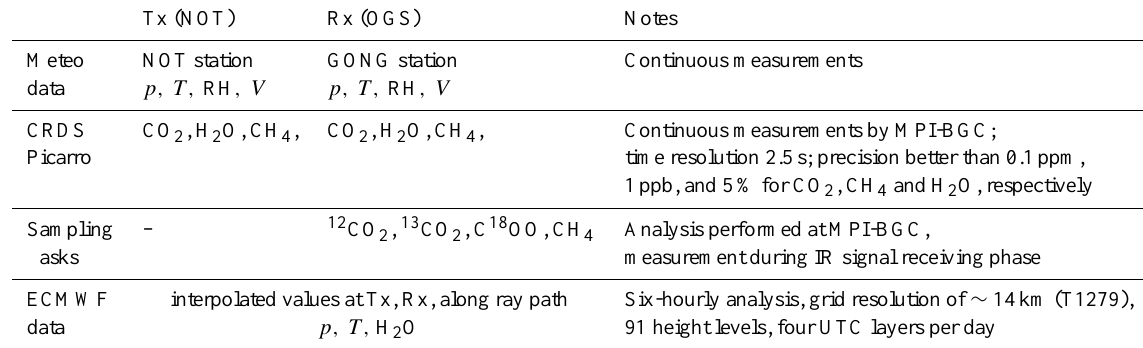
Table 3. Validation data set taken, or used from available sources, during the measurement campaign. For description see Sect.